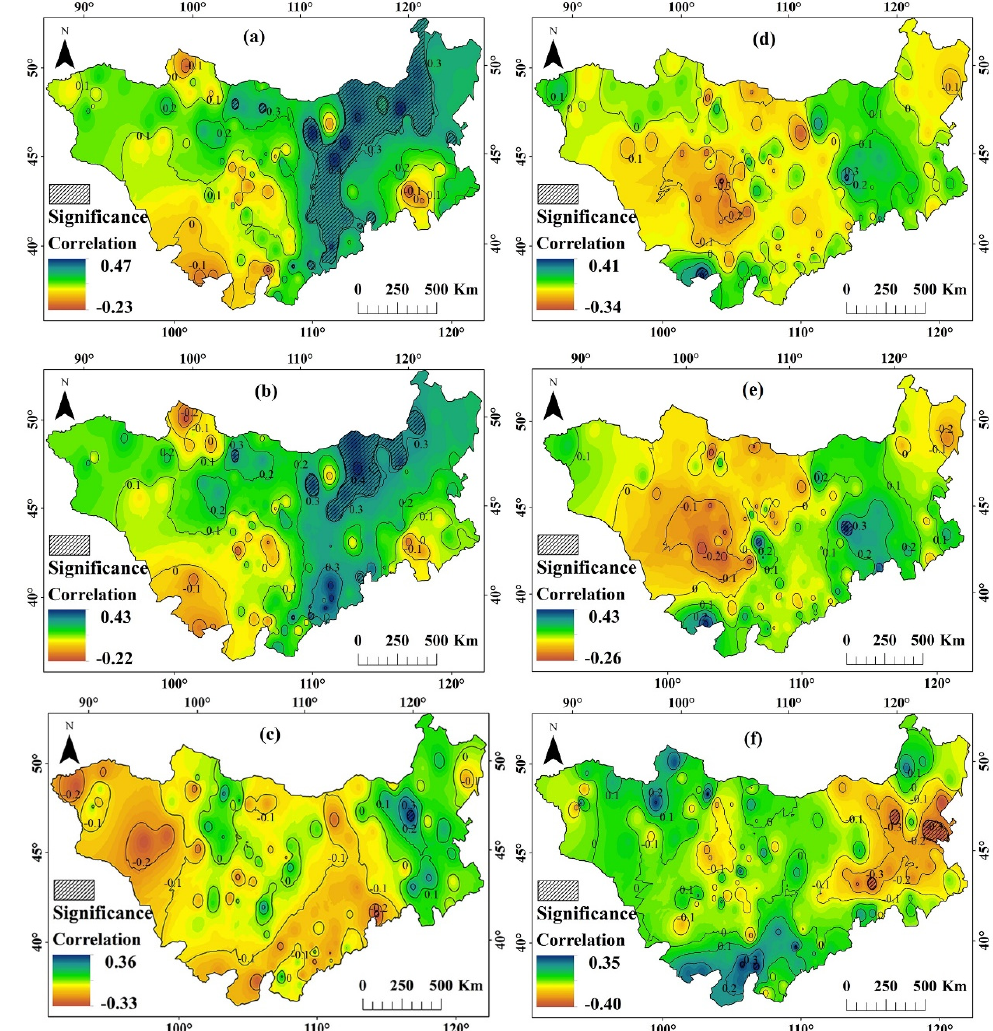
Figure 7. The spatial distribution of the correlation between precipitation and East Asian Summer Monsoon Index (( a ) Annual, ( b ) Summer, ( c ) Winter), the correlation between precipitation and Westerly Index (( d ) Annual, ( e ) Summer, ( f ) Winter) (Shaded indicates p < 0.05).